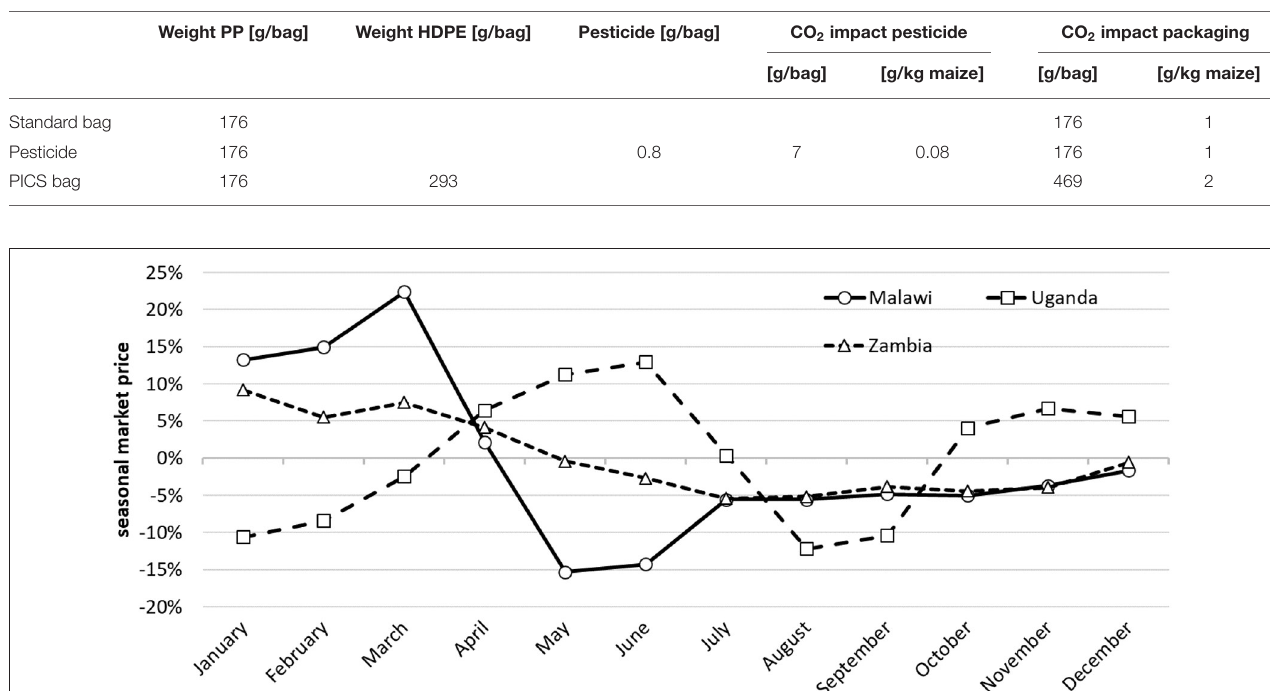
Frontiers in Sustainable Food Systems |